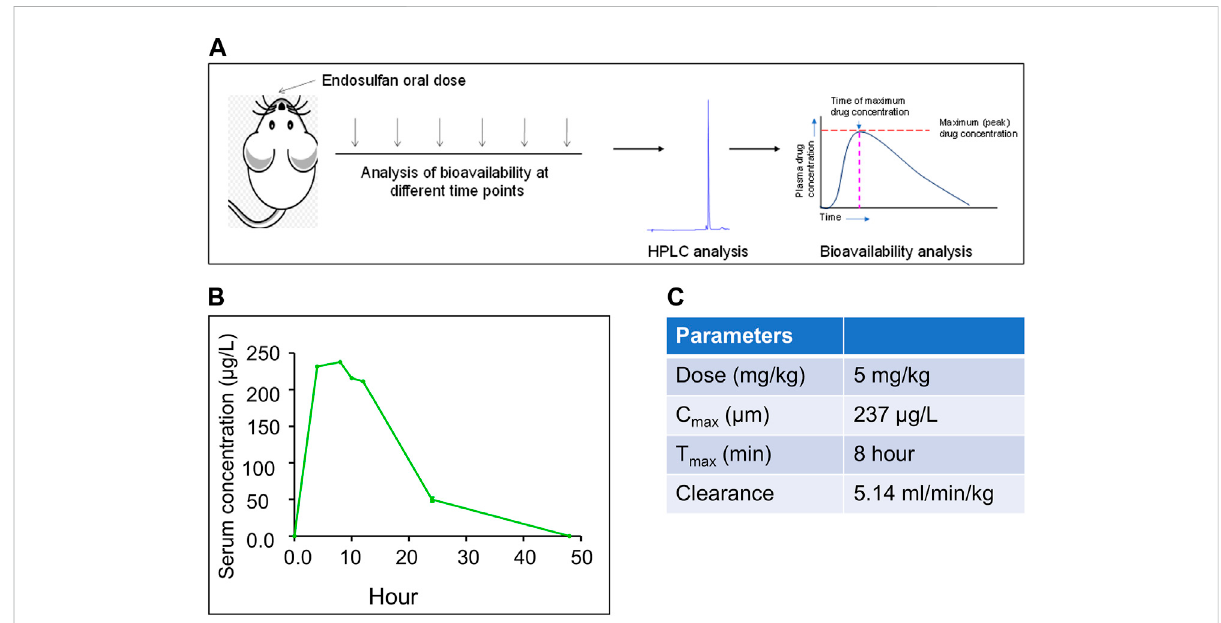
FIGURE 1 Evaluation of bioavailability of ES in mice when exposed to 5 mg/kg body weight of ES. (A) Schematic of the experimental strategy. HPLC analysis was performed using serum samples collected at different time points 4, 8, 10, 12, 24, and 48 h after oral ingestion of ES (5 mg/kg body weight, n = 3). (B) In vivo bioavailability analysis of ES in the serum of Balb/c mice at 4, 8, 10, 12, 24, and 48 h after exposure with ES (5 mg/kg body weight). Three animals were sacri fi ced for each time point, sera were collected and subjected to HPLC analysis at 214 nm wavelength. (C) Pharmacokinetics of ES in mice serum. The area under the curve (AUC) was calculated to obtain the maximum circulating concentration (C max ) and maximum time (T max ) to reach C max